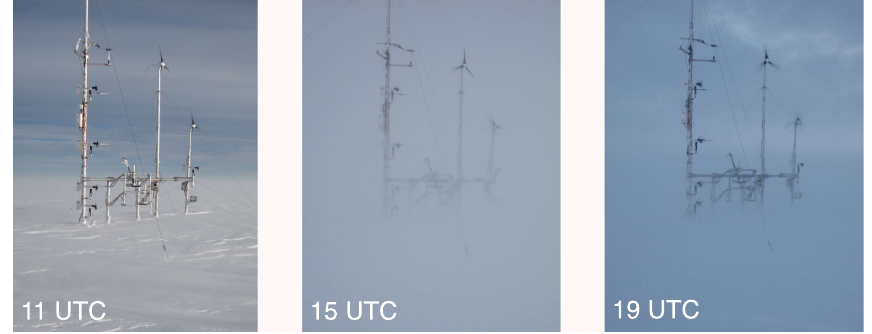
Fig. 13. Automatic camera images of the measurement system on 26 September at 11:00UTC, 15:00UTC and 19:00UTC. The automatic camera was positioned ∼ 10m away of the instrumental set-up.